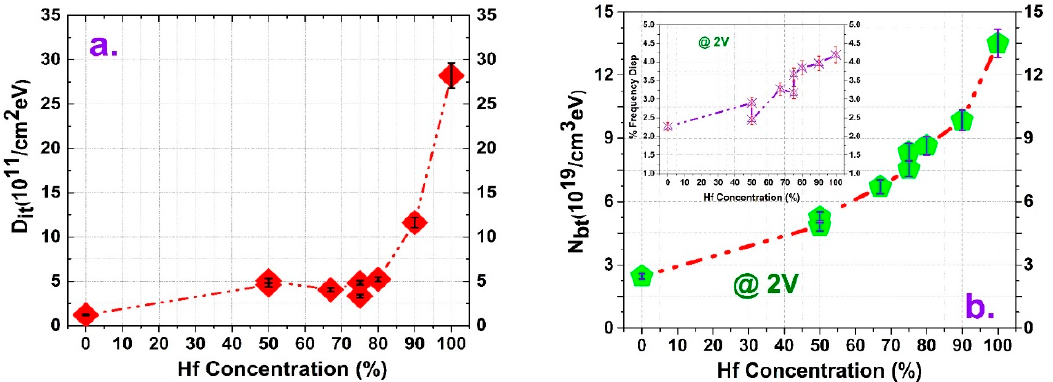
Figure 5. Trap characterization of HfAlO films with different Hf concentrations assumed by atomic-layer-deposition (ALD) cycle ratio: ( a ) interface trap density (D it ) and ( b ) border tap density (N bt ). Inset: frequency dispersion of accumulation capacitance at an applied bias of 2 V.